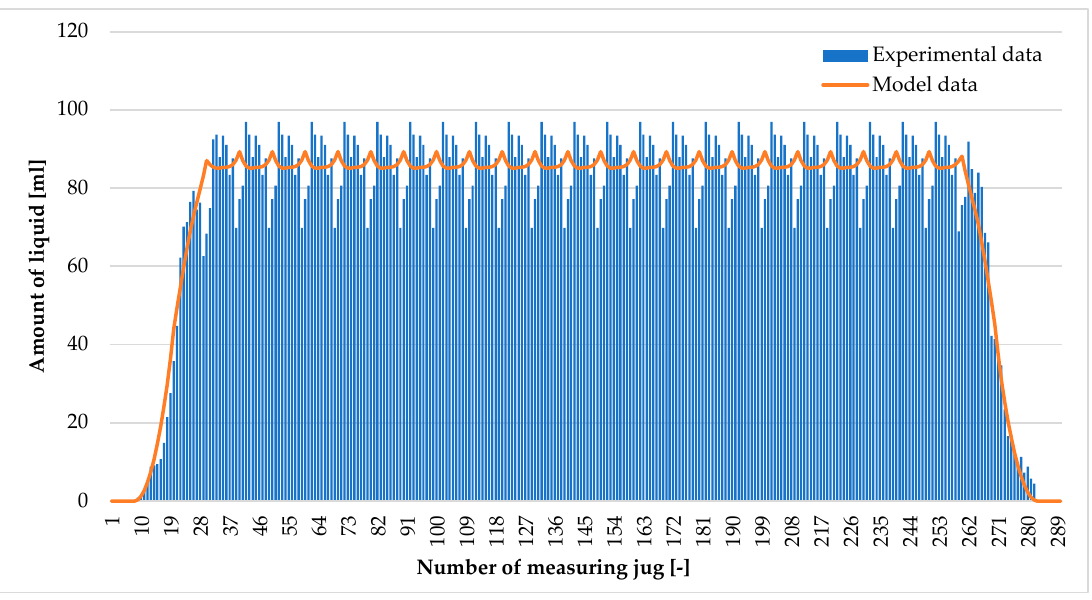
Figure 2. Spray fallout distribution for E Ż K 110 025 nozzles.